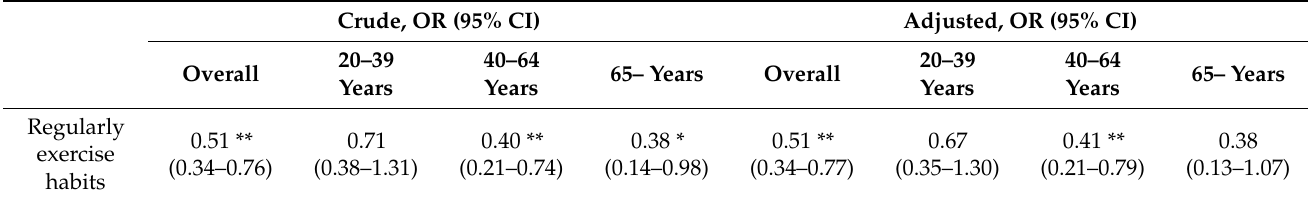
Table 3. Poor self-rated health and regularly exercise habits.